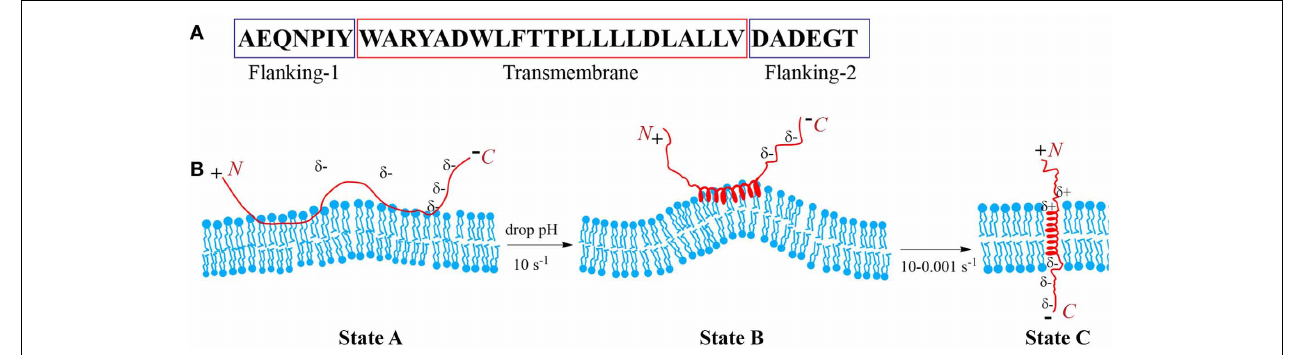
FIGURE 1 | Schematic presentation of pHLIP interaction with lipid bilayer of membrane. Sequence of the WT pHLIP (A) . At high and neutral pHs pHLIP is associated with the lipid bilayer of membrane. Negative charges of Asp, Glu, and C-terminus prevent partition of the peptide into bilayer. After a drop of the pH, some Asp/Glu residues are protonated, leading to an